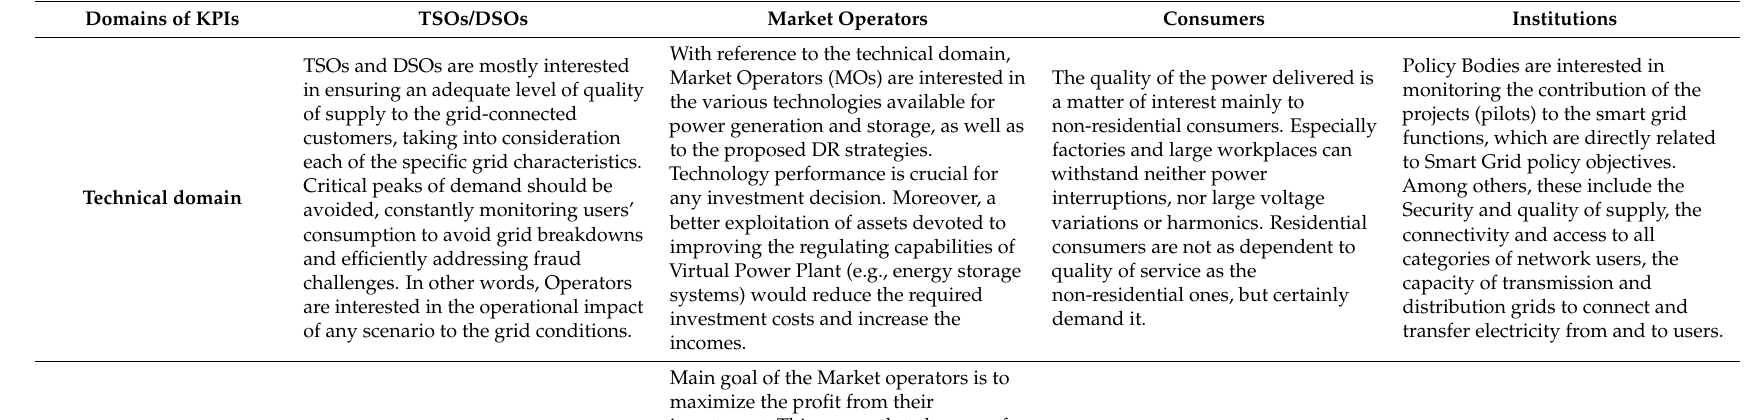
Table 3. The interest of each stakeholder to the assessment of each